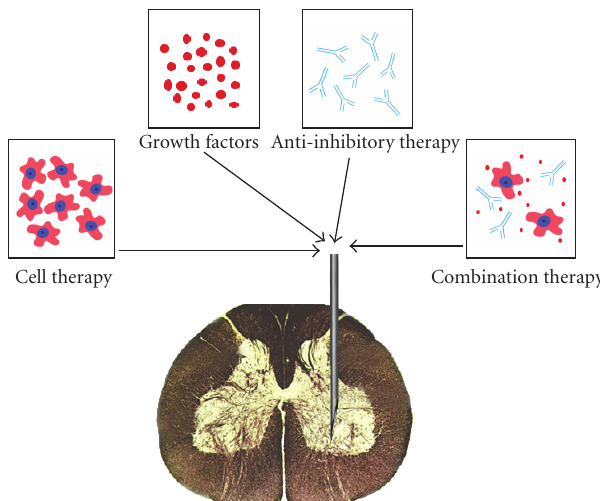
Figure 1: The individual and combination therapies currently being studied which show great